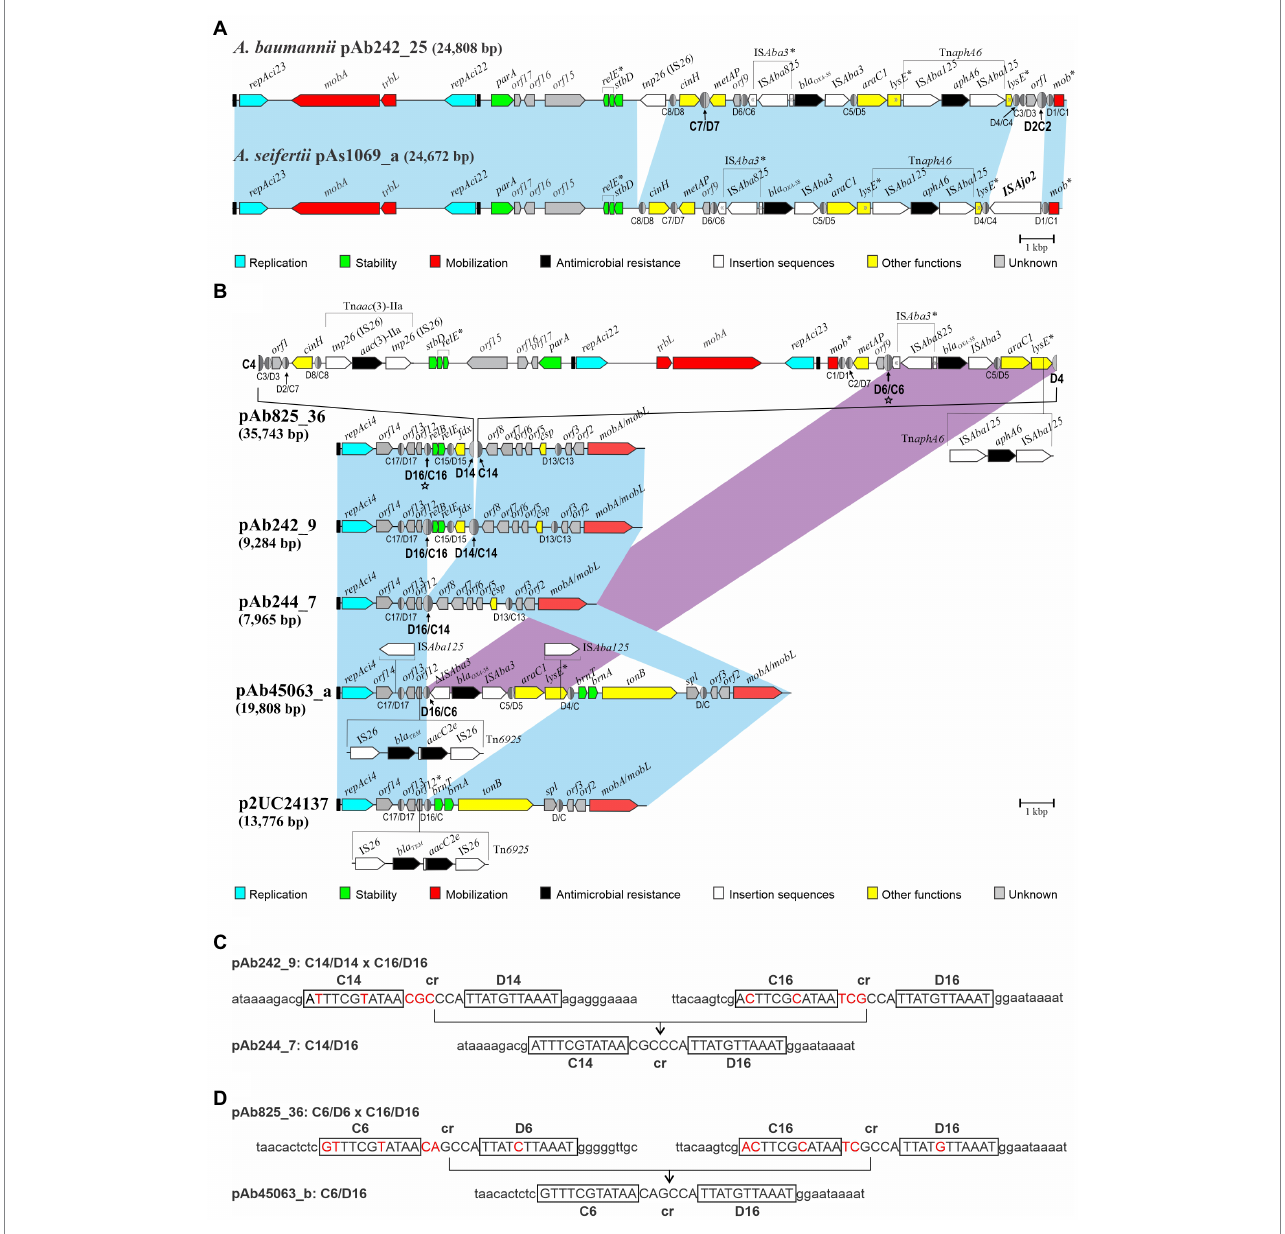
FIGURE 3 Structural comparisons between bla OXA-58 -containing Rep_3 plasmids carried by Acinetobacter baumannii Ab242/Ab825 strains with sequence-related plasmids deposited in databases described in other Acinetobacter strains. (A) Comparisons of bla OXA-58 -containing pAb242_25 with a similar repAci23 - and repAci22 -containing bi-replicon carried by the Acinetobacter seifertii 1,069 strain isolated in Brazil, pAs1069_a (GenBank accession number MK323040). The plasmids share 95% total sequence identity, all containing almost identical RMs encompassing bla OXA-58 - and aphA6 -resistant genes which show the same orientation in pAs1069_a as compared to pAb242_25. However, pAs1069_a contains an extra IS Ajo2 -like element at the Tn aphA6 -proximal end of the RM (1,482 bp; nucleotide positions 22,311 to 23,792), an insertion that is concomitant with the deletion of around 490 bp containing the C2/D2 and C3/ D3 sites in pAb242_25. For other details on plasmid structures see the legend to Figure 1. (B) Comparisons of the pAb825_36 tri-replicon structure characterized in this work with different plasmids containing backbones endowed with a repAci4 replication module and mobA / mobL genes described in other A. baumannii CC15 strains. The light-blue shaded background interconnecting the different plasmid structures denote shared regions of sequence homology between plasmids. ISs or IS-based transposons found in a given plasmid but not in others within these otherwise homologous regions were represented either above or below the corresponding structures. The magenta-shaded background denotes homologous regions carrying similar pXerC/ D-bounded bla OXA-58 -containing RMs between pAb825_36 and pAb45063_a. The pXerC/D sites constituting sister pairs mediating SSR events, or resulting from these events, have been arbitrarily enlarged. The directly-oriented C6/D6 and C16/D16 sites in pAb825_36 (labeled with stars ★ ), proposed here to mediate an intramolecular SSR event conducing to a pAb45063_a-like plasmid as one of the resolution products, have been also arbitrarily enlarged. GenBank accession numbers: pAb244_7: MG520098; pAb45063_a: MK323042. For other details on plasmid structures see the legend to Figure 1. (C) Sequence comparison evidence indicating the existence of an intramolecular SSR resolution event in pAb242_9 mediated by the directly-oriented C14/ D14 and C16/D16 sites conducing to the generation of pAb244_7 containing a C14/D16 (hybrid) site. The pXerC/D core sequences of each site are displayed in uppercase letters, where the XerC and XerD half-sites have been additionally boxed. For a better visualization of the SSR event the nucleotide differences between core sites on the substrate plasmid have been highlighted in red, and additional sequences (10 bp in each case) at the immediate vicinities of each specific half-site have been included. (D) Same, indicating an intramolecular SSR resolution event in a pAb825_36-like substrate plasmid mediated by the directly-oriented C6/D6 and C16/D16 sites resulting in the generation of a pAb45063_a-like plasmid containing a C6/D16 (hybrid)